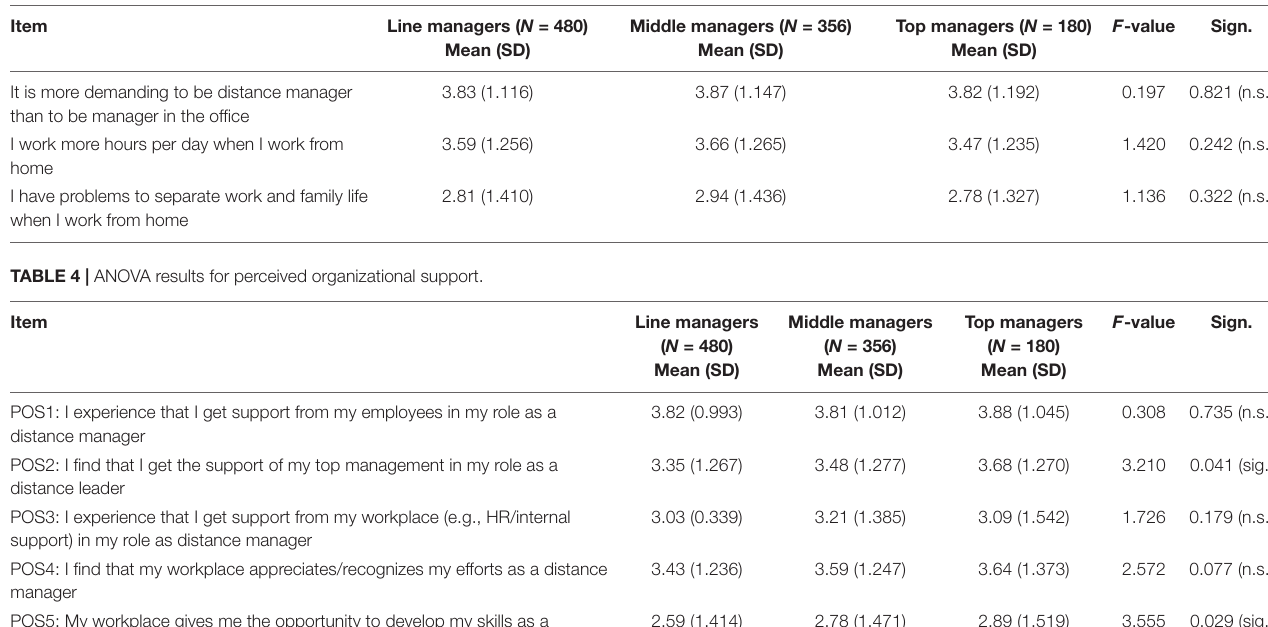
TABLE 3 | Work extensification of managers at different levels (ANOVA).